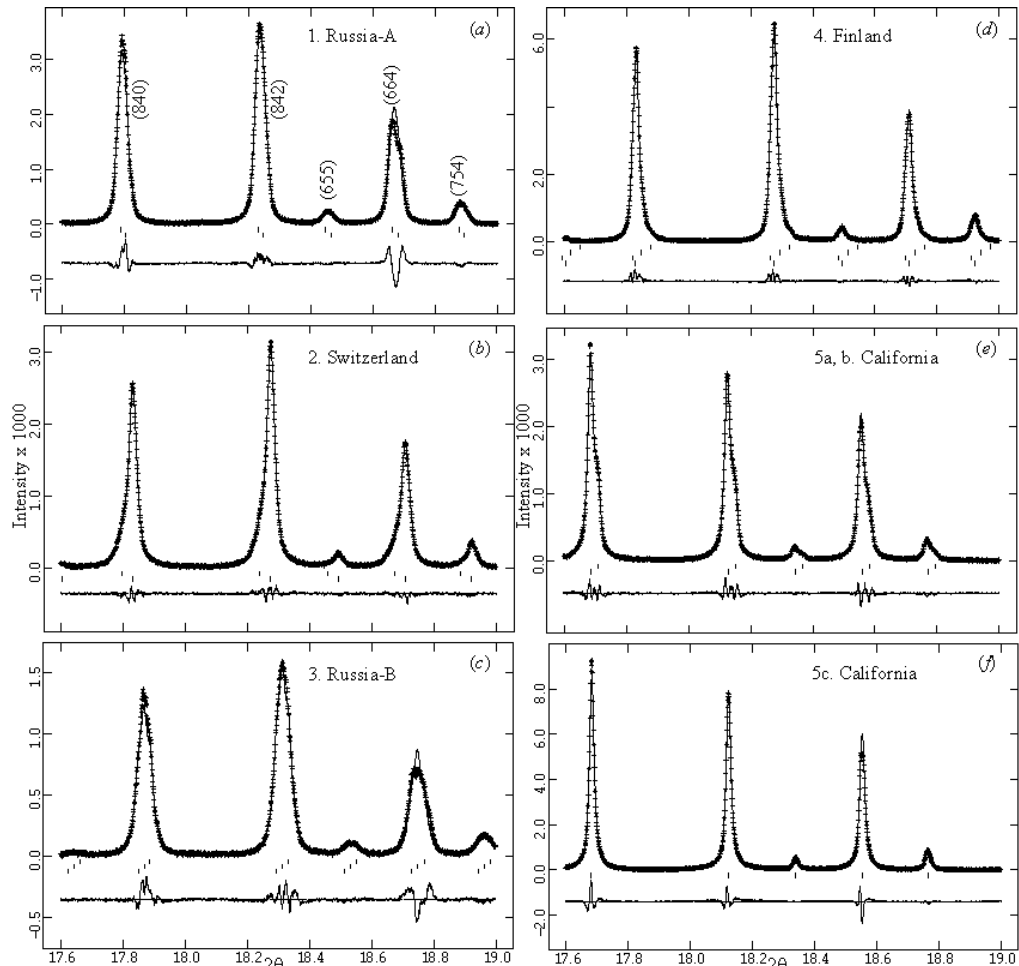
Figure 8. Expanded scale for the same set of reflections for five samples: ( a ) 1. Russia-A, ( b ) 2. Switzerland, ( c ) 3. Russia-B, ( d ) 4. Finland, ( e ) 5a, b. California, and ( f ) 5c. California. For the multiple-phase cubic samples, each reflection peak is split, asymmetrical, or broad (a, b, and e = two phases, c = three phases, d = four phases), whereas a cubic single-phase garnet has sharp, narrow, and symmetrical peaks (f).